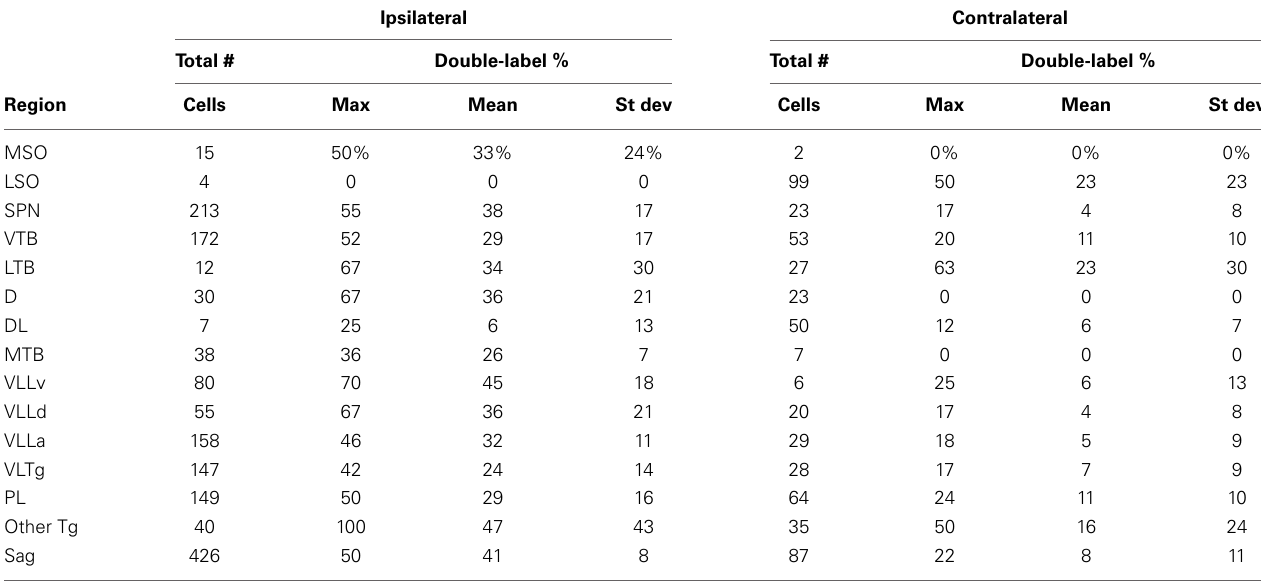
Table 3 | Quantitative summary of double-labeled cells. Ipsilateral Contralateral Double-label